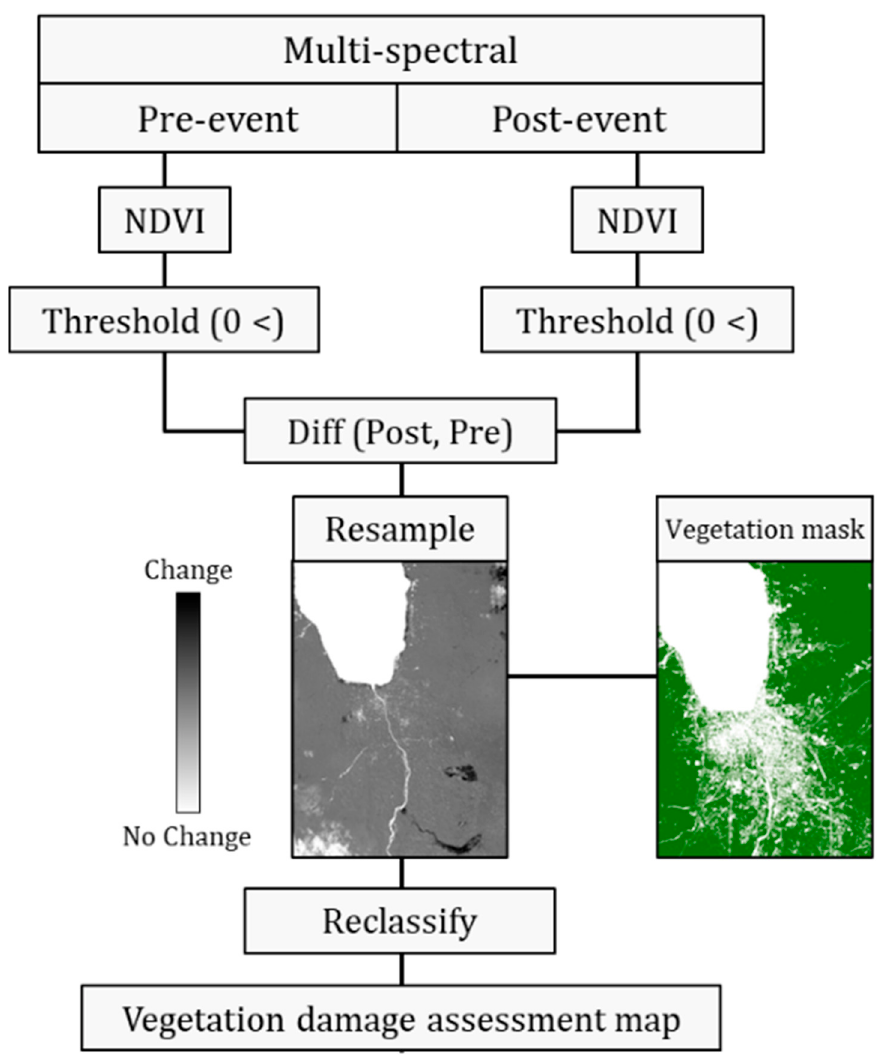
Figure 2. Vegetation damage assessment process outline. Light shades in the difference map repre- sent stable vegetation areas with no or slight changes and dark shades represent vegetation areas with changes.